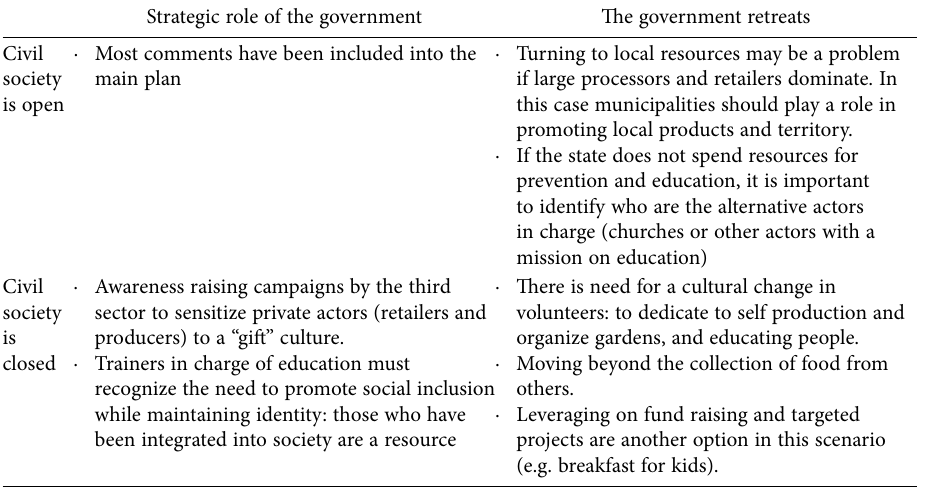
Table 2. Contingency plan for “education”. Strategic role of the